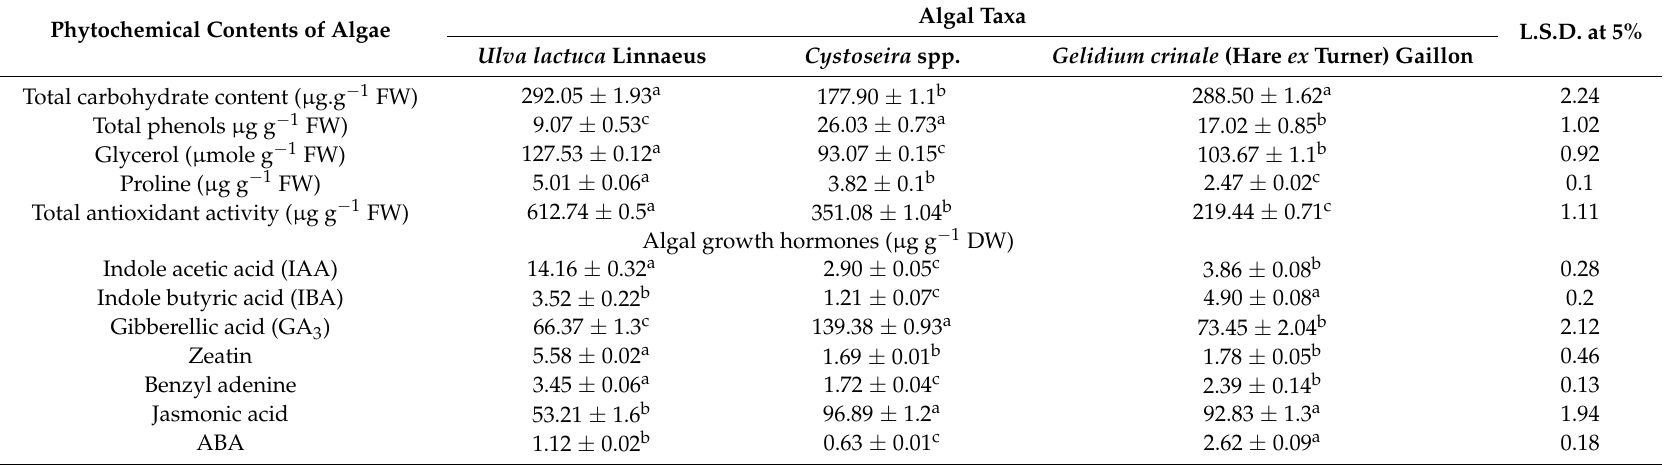
Table 1. Phytochemical analyses of the studied marine macro-algae. Data are presented as the mean ± SD ( n = 15). Phytochemical Contents of